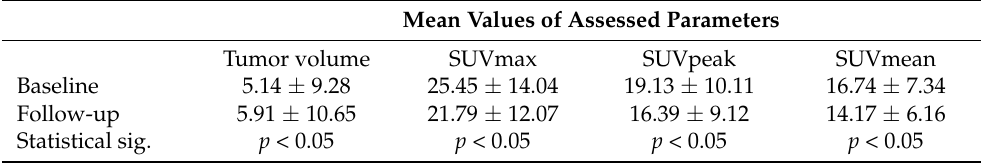
Table 3. Assessed parameters’ mean values